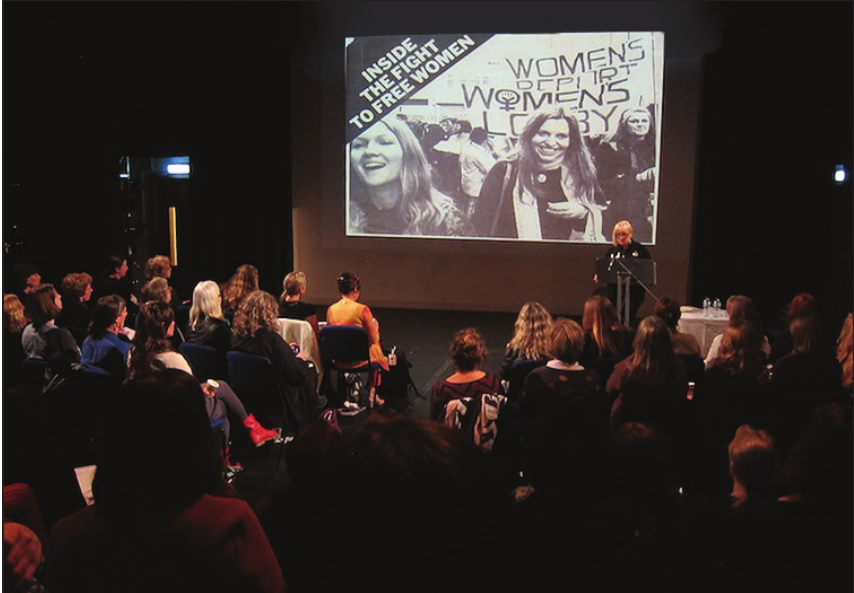
Figure 1: Griselda Pollock talking during the ‘Motherhood and creative practice’ conference, 2 June 2015 Image by Christa